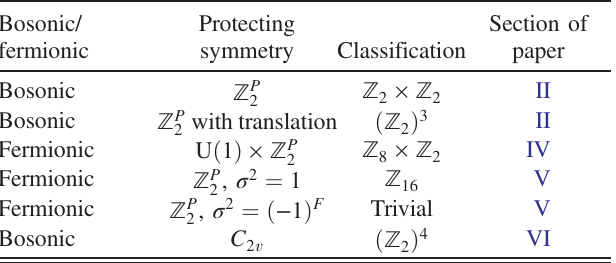
TABLE I. Summary of the classifications obtained for point group SPT phases in three dimensions. The first column indicates whether we are considering bosonic or fermionic systems, the second column gives the protecting symmetry, and the third column gives the classification. Z P 2 denotes reflection symmetry, σ the reflection operation, and ð − 1 Þ F the fermion parity operator. C 2 v is the three-dimensional point group generated by two perpendicular mirror reflections. Translation refers to discrete translation symmetry normal to the mirror planes. The last column shows the section of the paper where each classification is